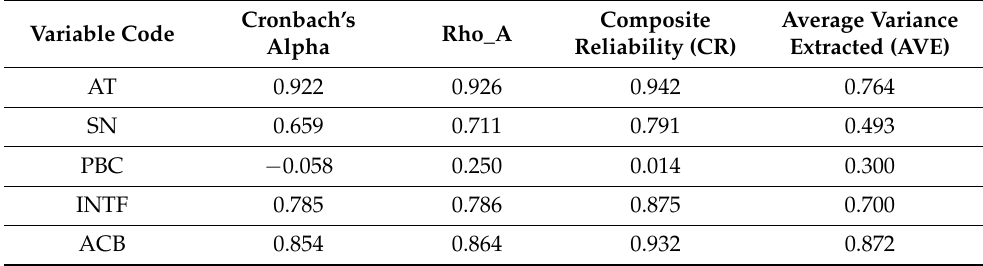
Table 6. Reliability and Validity. The “Rho_A” coefficient also considered to check the reliability of the latent variable construct scores, as defined in Dijkstra and Henseler